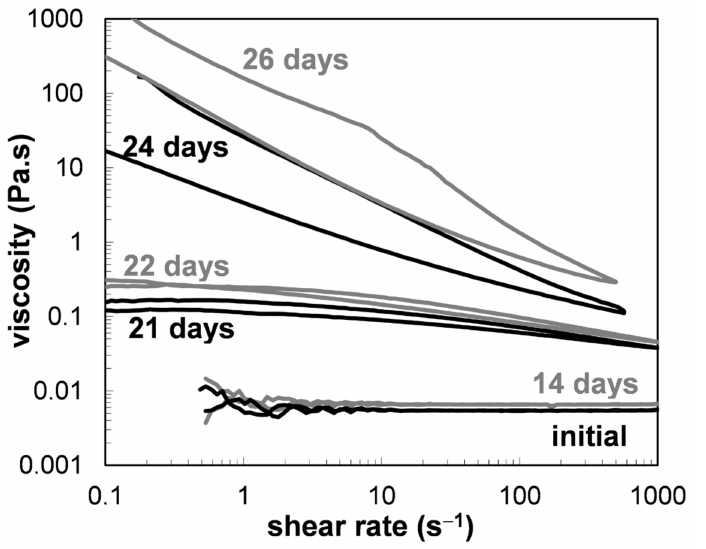
Figure 10. Flow curves (the dependence of viscosity on shear rate) for WO 3 sols at T = 23 ◦ C. The rheological properties of WO 3 sols were, at different times during the gelation pro- cess, followed also with non-destructive oscillation tests in the range of linear viscoelastic response (Figure 11). At the beginning, immediately after the preparation, the sol exhibited Newtonian flow behavior as only viscous contribution G (cid:48)(cid:48) was present, which linearly increased with the frequency of oscillation. As it was observed during flow tests, at 21st day some changes were observed also with frequency tests. Newtonian character of